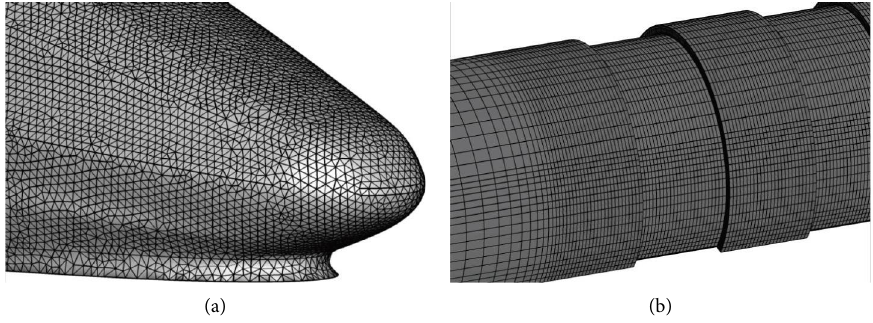
Figure 3: Model mesh. (a) Mesh of the train head. (b) Mesh of the lining.